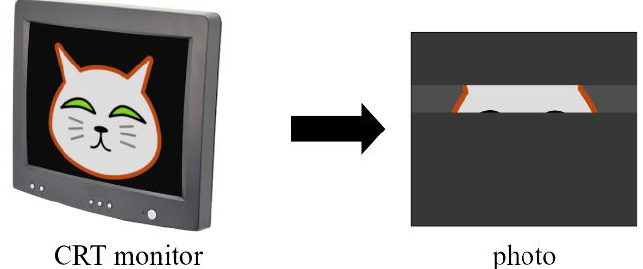
Figure 10. Measurements using a CRT monitor.